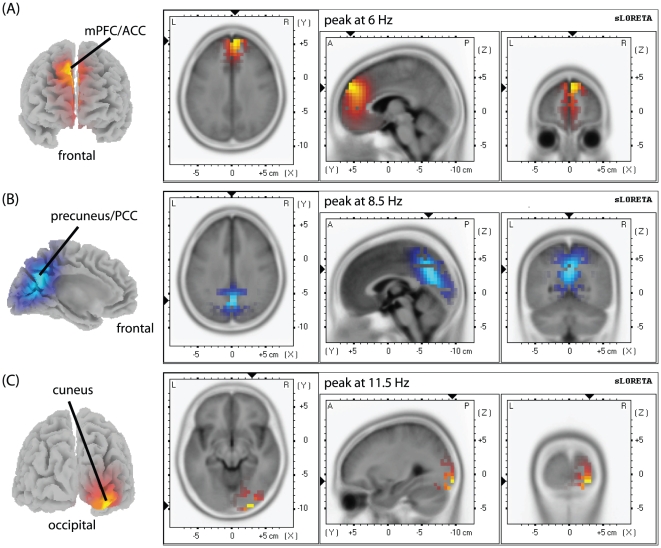
EEG source localization (sLORETA) activation maps for the contrast ‘ss5–ss2’.(A) Theta (5–7 Hz) band power increased (p<0.1) with load at the border of the MPFC and the ACC. (B) Alpha1 (8–10 Hz) showed decreased (blue) activity (p<0.05, corrected for multiple comparisons) at the border of the precuneus and the PCC with an increase of load. (C) Alpha2 (10–13 Hz) showed positive load modulations (p<0.05, corrected for multiple comparisons) in the right middle occipital gyrus (cuneus, BA 18). The t-values are plotted onto a MRI template.